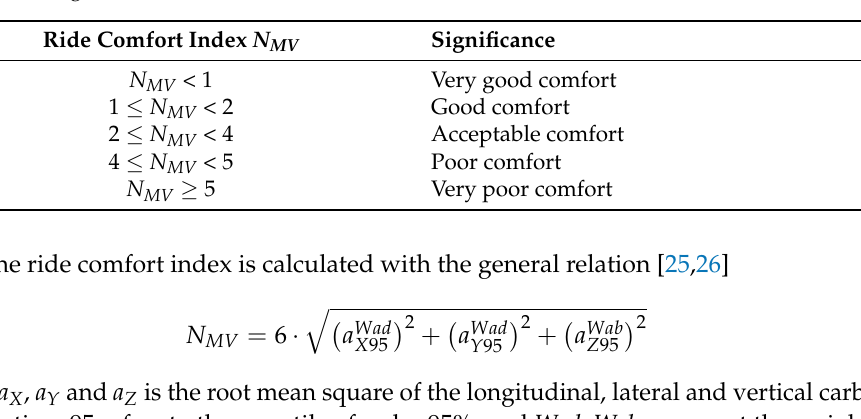
Table 2. The significance of the ride comfort index N MV